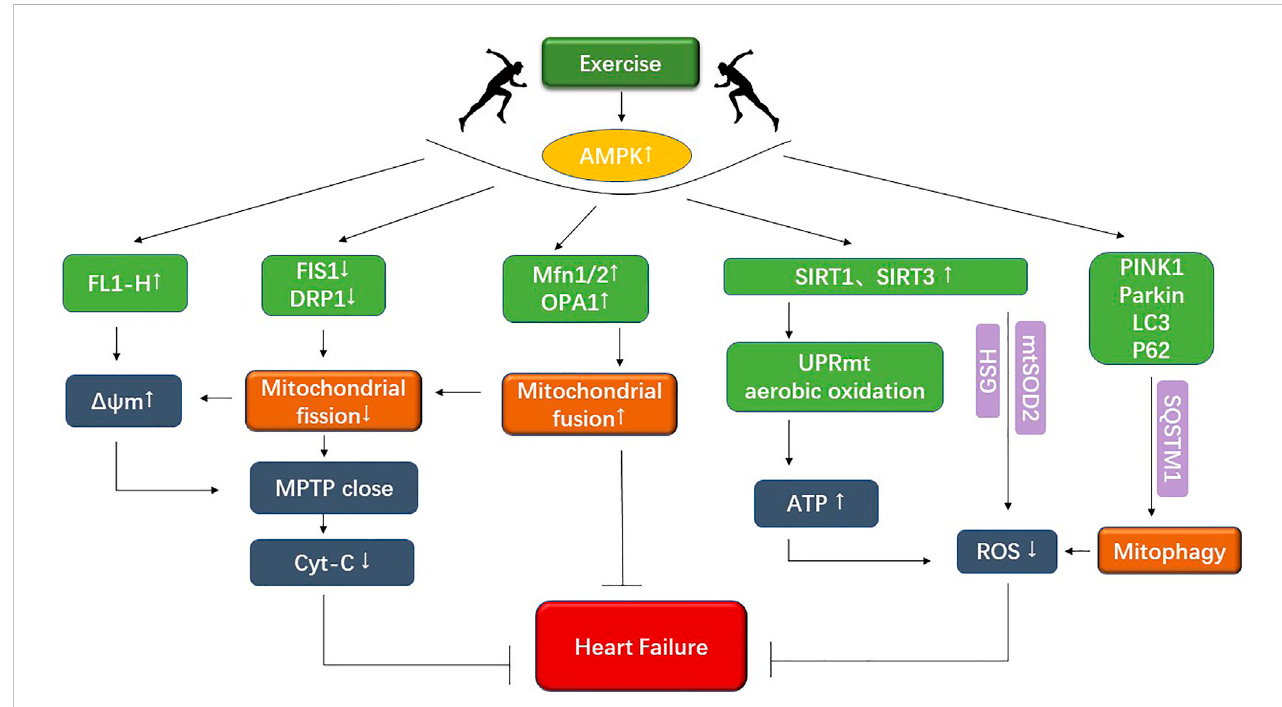
FIGURE 2 The fi gure shows that exercise improves mitochondrial dynamics as well as mitochondrial energy metabolism under cardiovascular